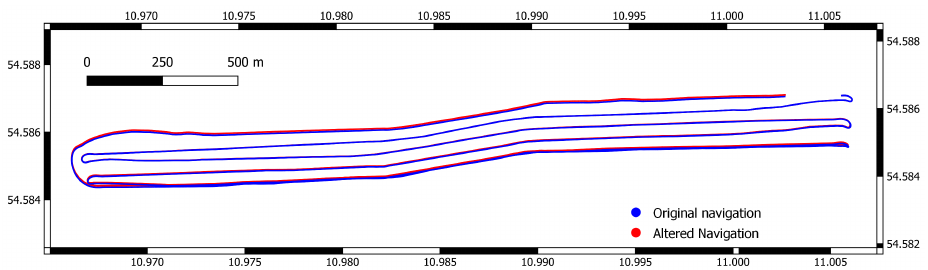
Figure 6. Original and altered navigation. In the beginning of the survey, original and altered navigation are still aligned, while the difference is most prominent near the end. Coordinates are in UTM (zone